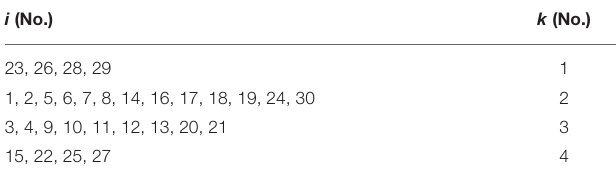
TABLE 5 | Allocation results according to Model